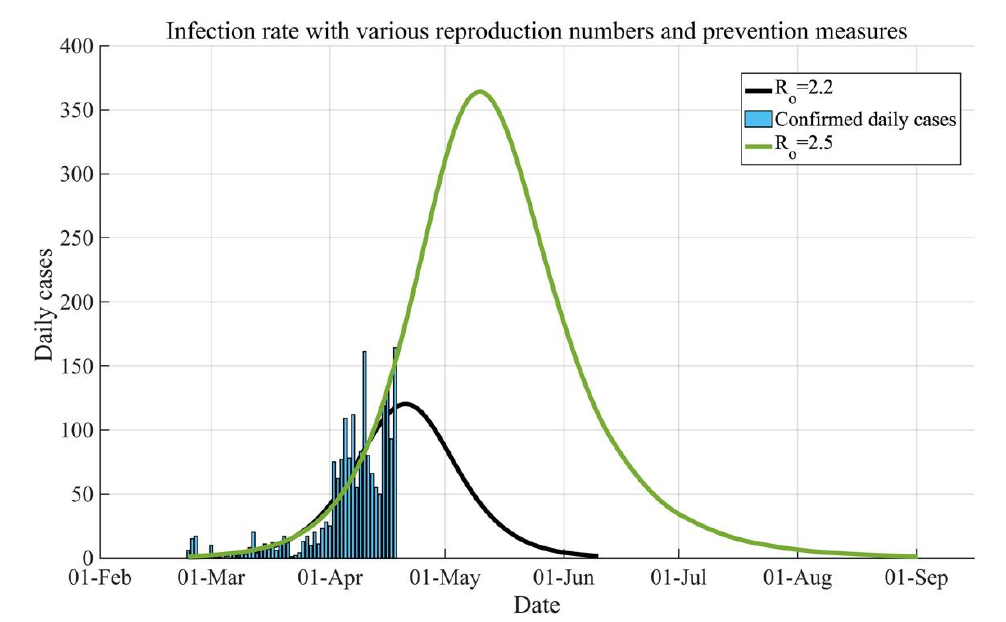
Figure 4. A comparison between the peaks of the current estimated reproduction number ( R o = 2.2) and a higher reproduction number of R o = 2.5. Table 5. Susceptible – infected – recovered (SIR) simulation results with R o = 2.2 and R o = 2.5.